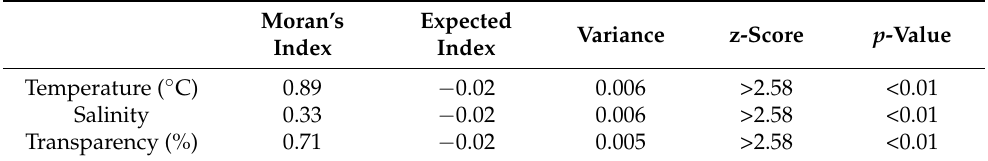
Table 2. Spatial autocorrelation using Global Moran’s I (GMI) for the Cassiopea andromeda distribution in Cala performed on temperature ( ◦ C), salinity, and transparency (%). GMI expected index, variance, z-score, and p -value are also reported.